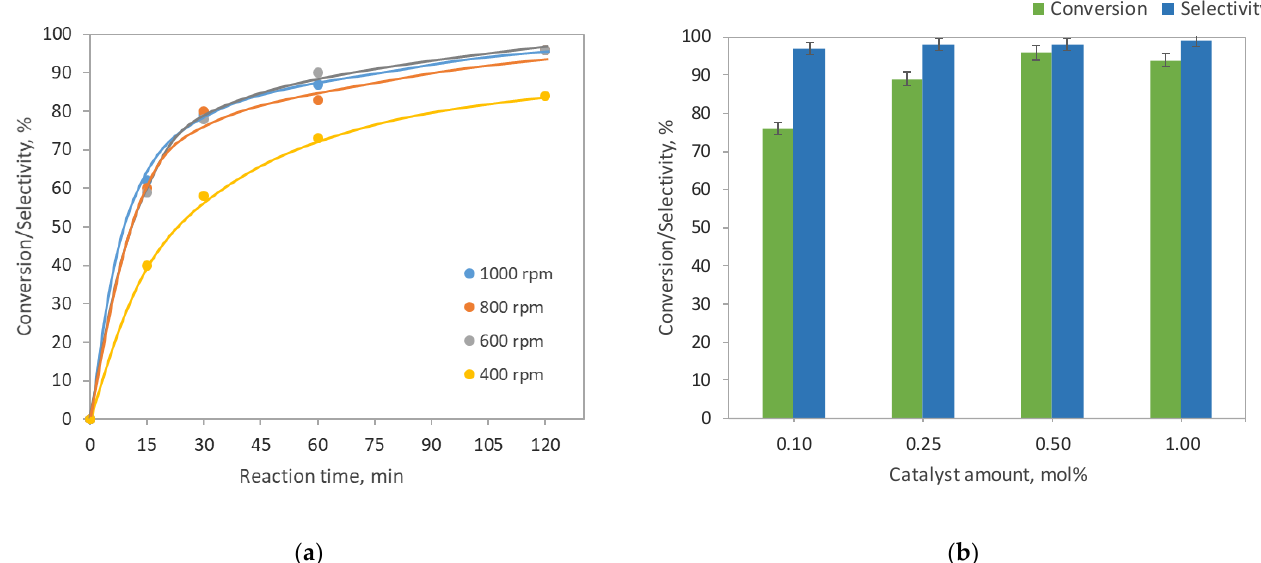
Figure 1. The effect of ( a ) agitation speed; ( b ) catalyst amount on hydroxypivaldehyde synthesis. Reaction conditions: ( a ) IBA:FA molar ratio 1.2:1; 40 wt.% K 2 CO 3 ; PEG 600-PS, 0.5 mol%; 40 °C; 2 h; ( b ) IBA:FA molar ratio 1.2:1; 40 wt.% K 2 CO 3 ; PEG 600-PS; 600 rpm; 40 °C; 2 h. Each experiment was performed three times.